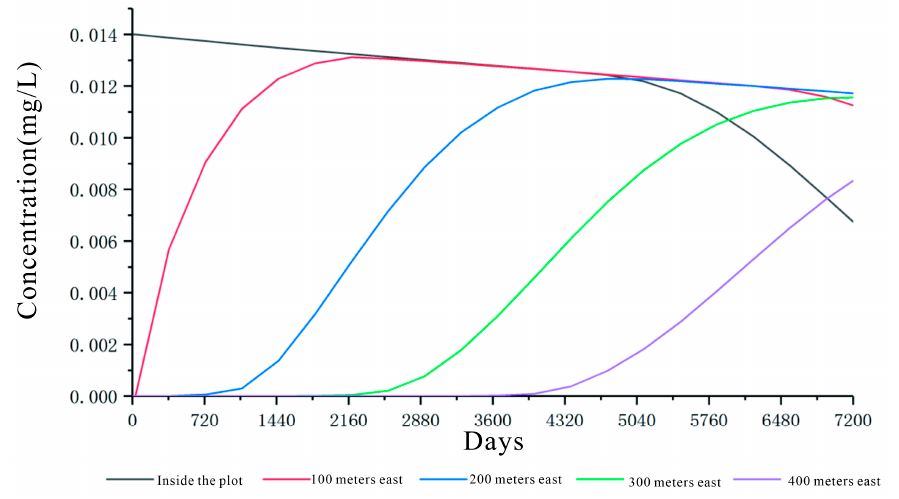
Figure 12. Pb concentration variation curve.